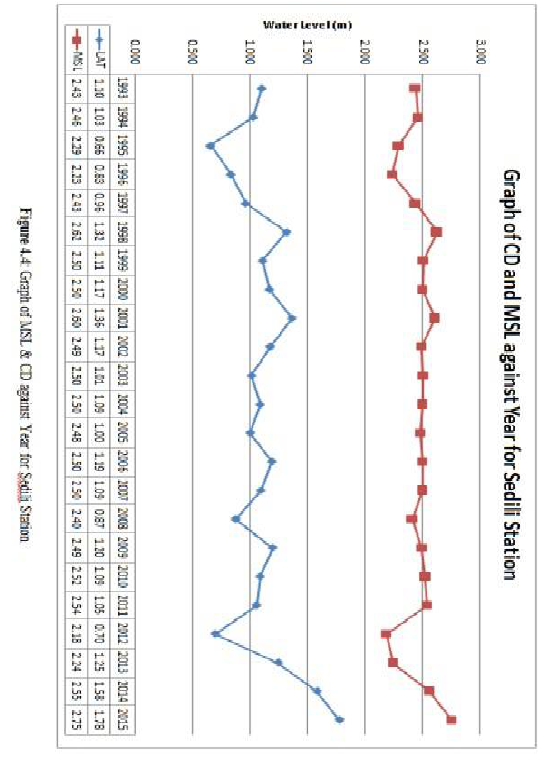
Figure 10. Sedili Tide Station